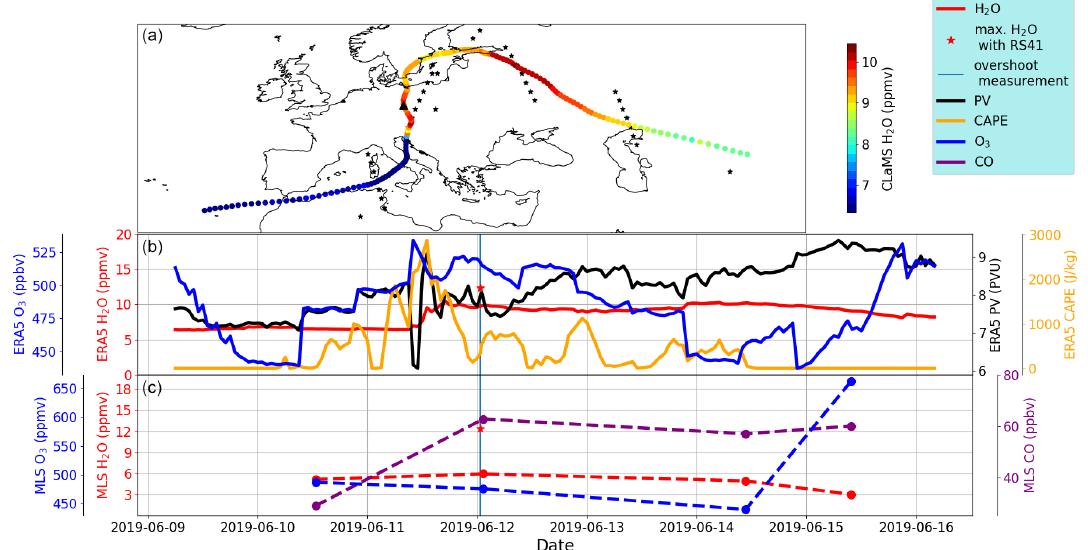
Figure 10. Same as in Fig. 9 but for case 2. The time of the measurement is marked with a vertical blue line, and the observed maximum water vapor mixing ratio from RS41, within the pressure levels of 139 and 155hPa, is shown with red star in each panel.